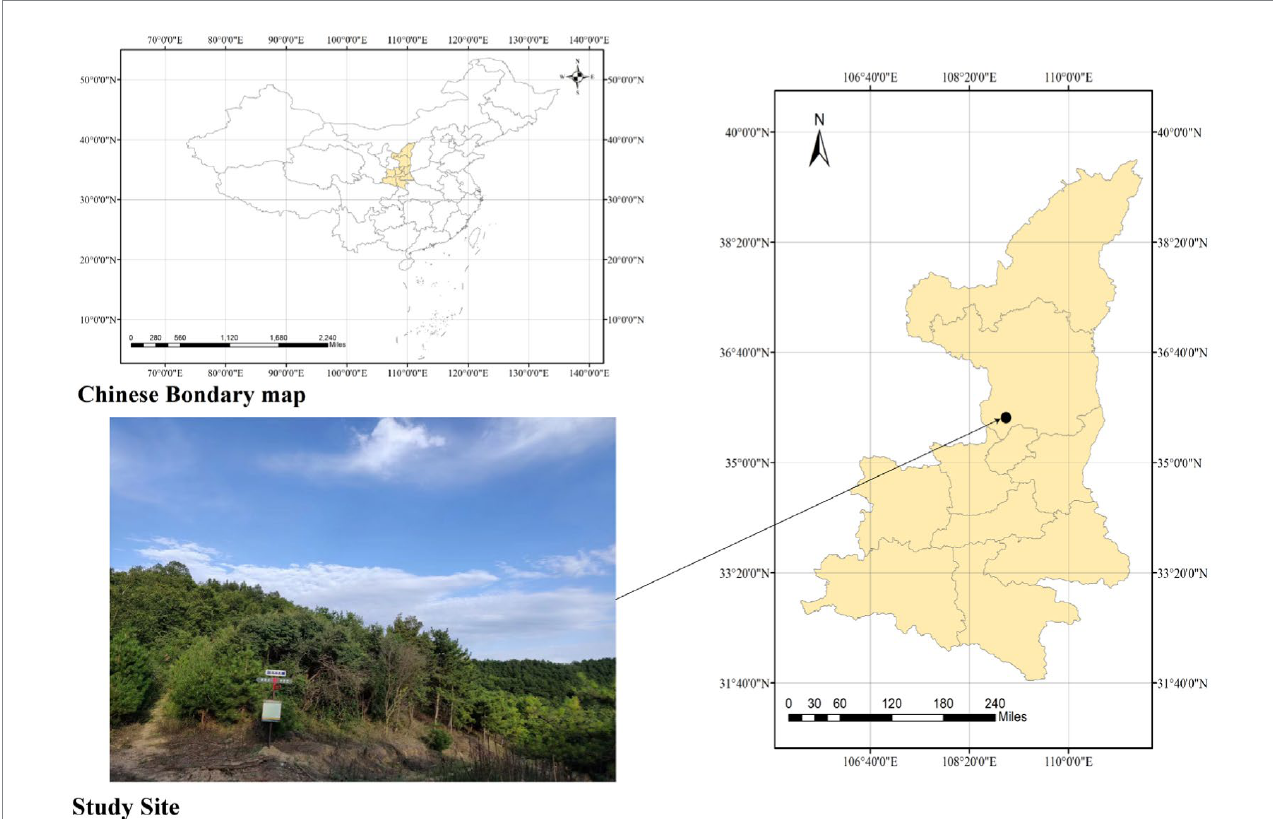
FIGURE 1 Map of study site. The Shuanglong Forest Farm is located in Shuanglong Town, Huangling County, Yan’an City, Shaanxi Province, China. It is located in the Ziwuling Mountains and is a natural secondary